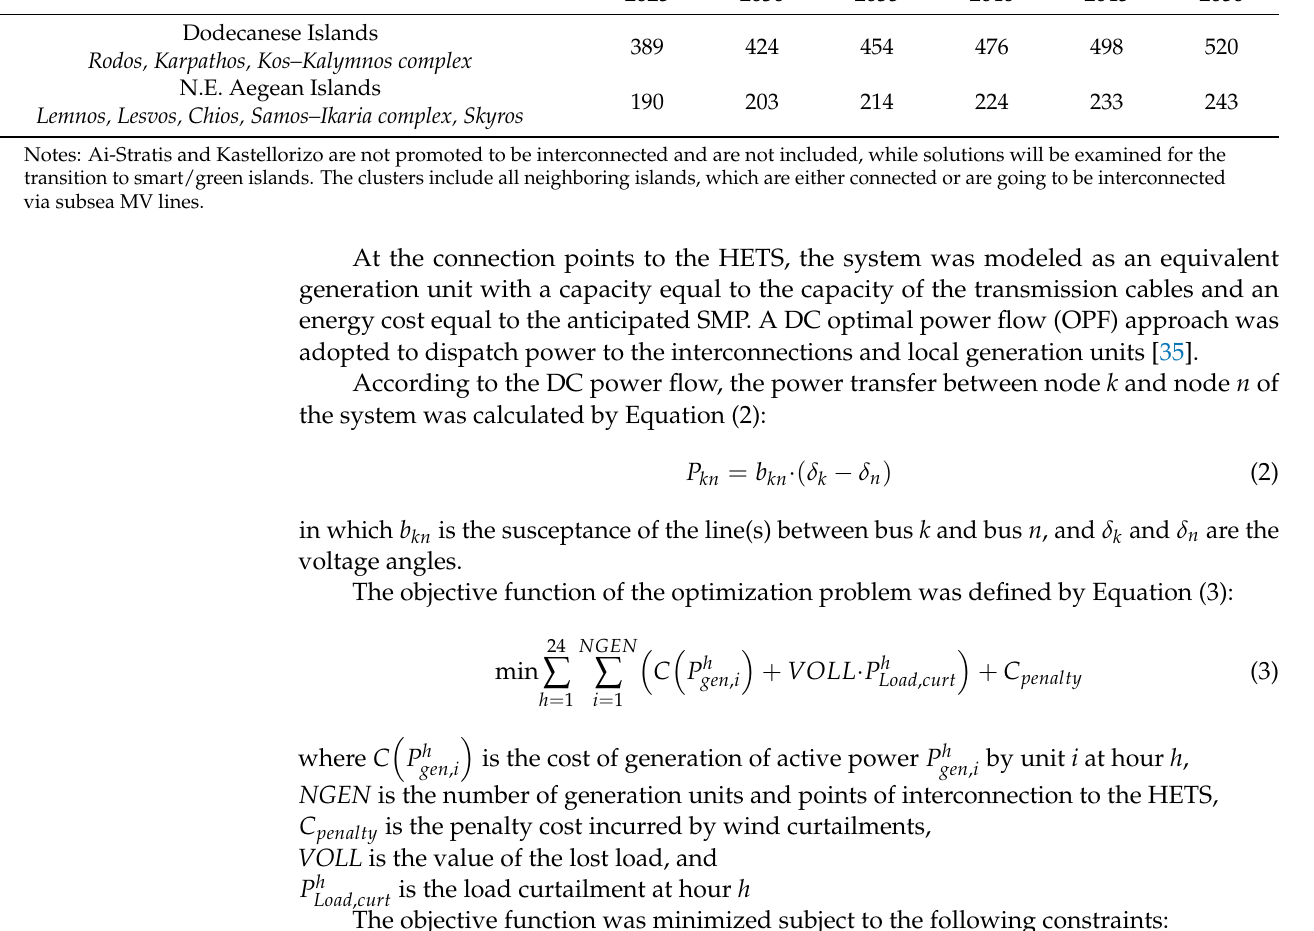
Table 3. Peak (maximum) demand forecasting per cluster for the period of 2025–2050. Cluster Peak Demand